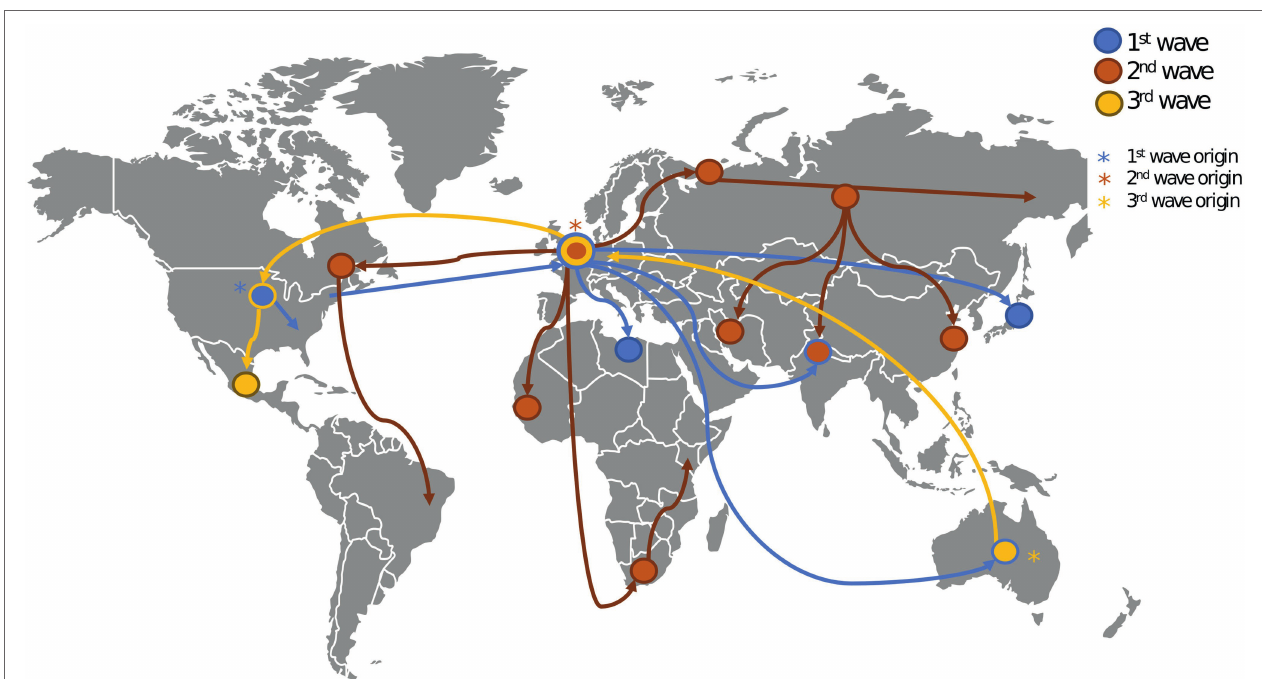
FIGURE 2 | Geospatial spread of influenza during the 1918 pandemic. This figure shows the origin (marked with asterisks) and spread (marked with edges) of the three waves of the 1918 influenza pandemic (Earth.Org, 2022). The first wave originated in the United States (US). and spread throughout Europe and the rest of the world. The second wave originated in Europe and spread through the US, Europe, Asia and Africa. The third wave originated in Australia and spread through Europe and the